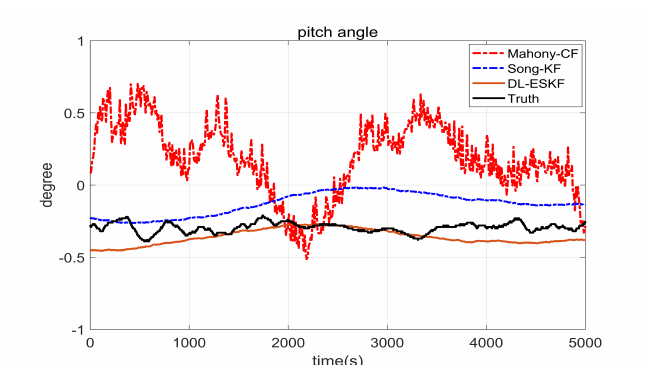
Figure 8. Roll angle under static conditions.